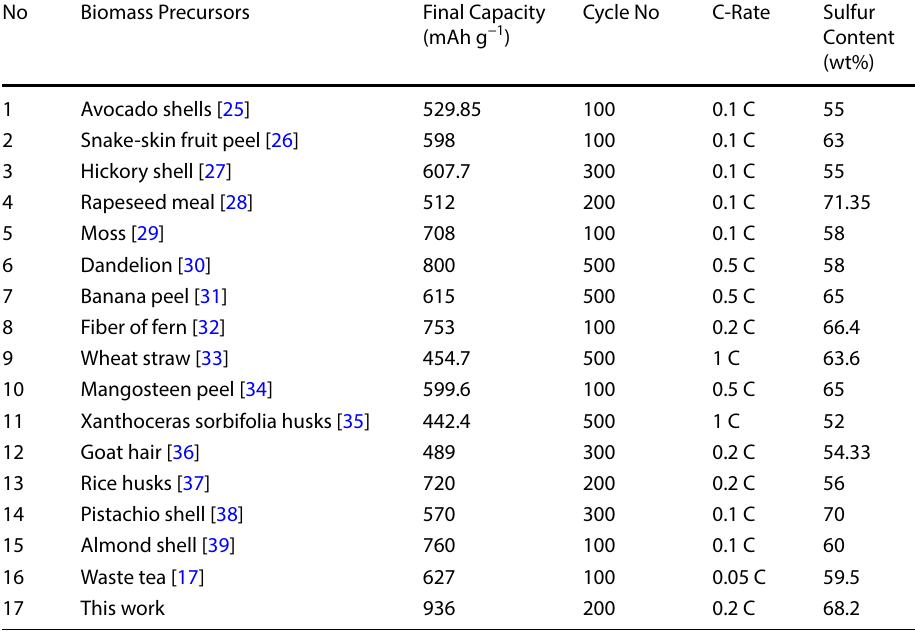
Table 3 Comparison of electrochemical performances of various biomass based porous carbons as composite cathodes for LiS